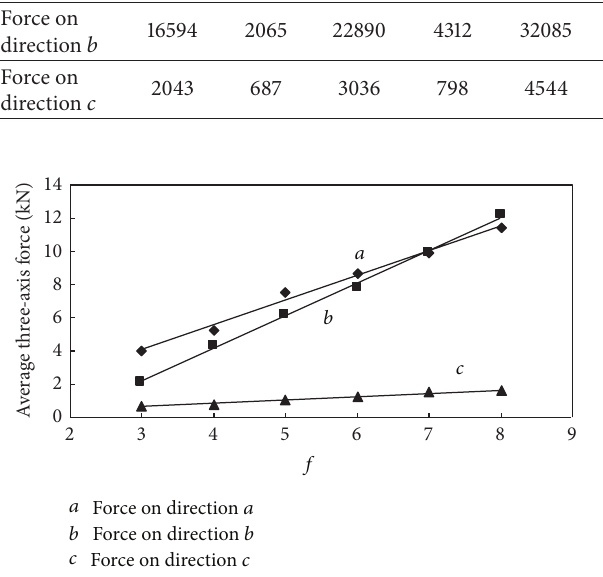
Figure 16: Relationship between average three-axis force and 𝑓